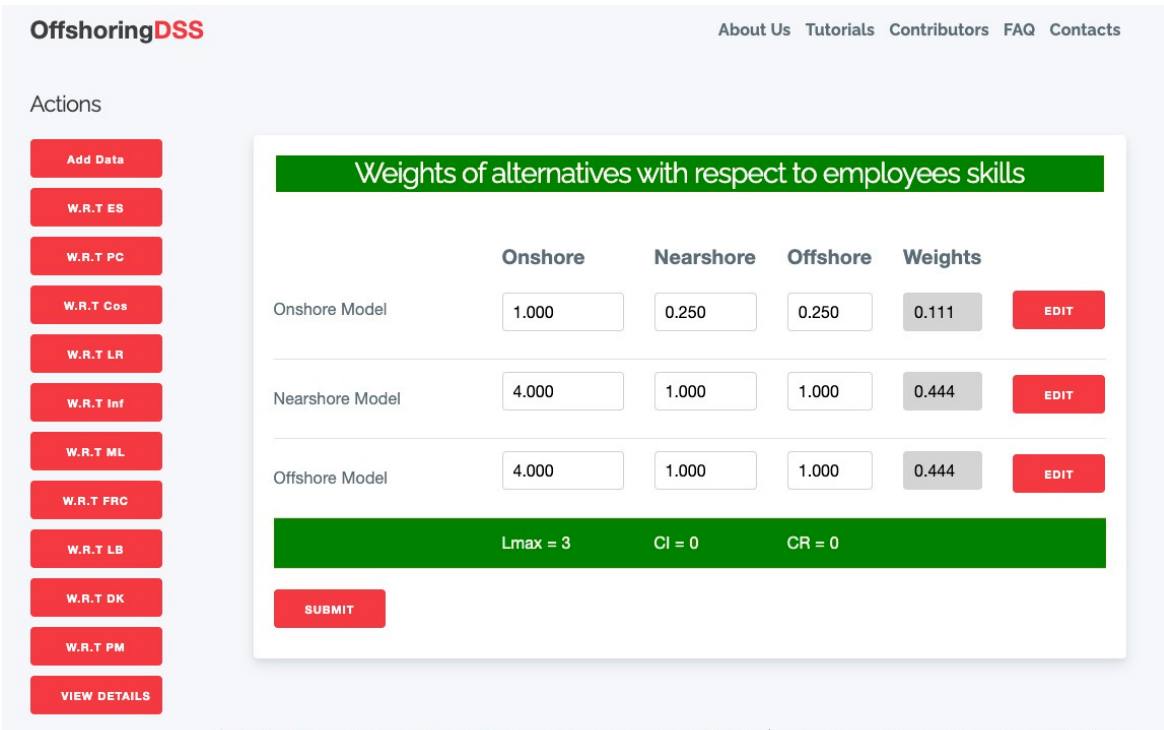
Figure 10. Weights of alternatives.